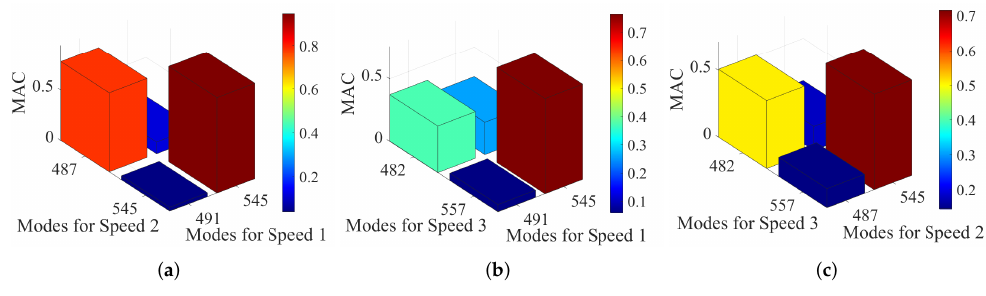
Figure 7. ( a ) MAC between speeds 1 and 2 for Ref measurement. ( b ) MAC between speeds 1 and 3 for Ref measurement. ( c ) MAC between speeds 2 and 3 for Ref measurement. MAC matrices comparing the correlation between the rotational speeds.